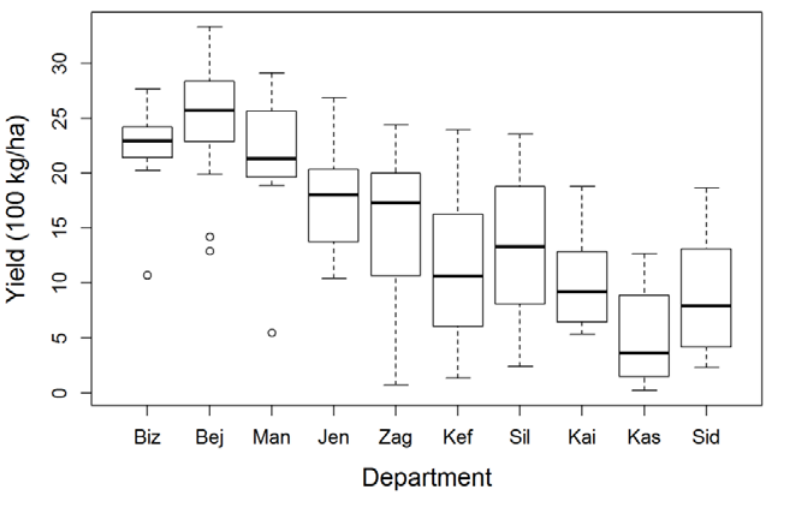
Figure 2. Box-and-whisker plot showing wheat yield for years 1999–2011. Medians, quartiles, and extreme values are given. Department on the x-axis are ordered from North to